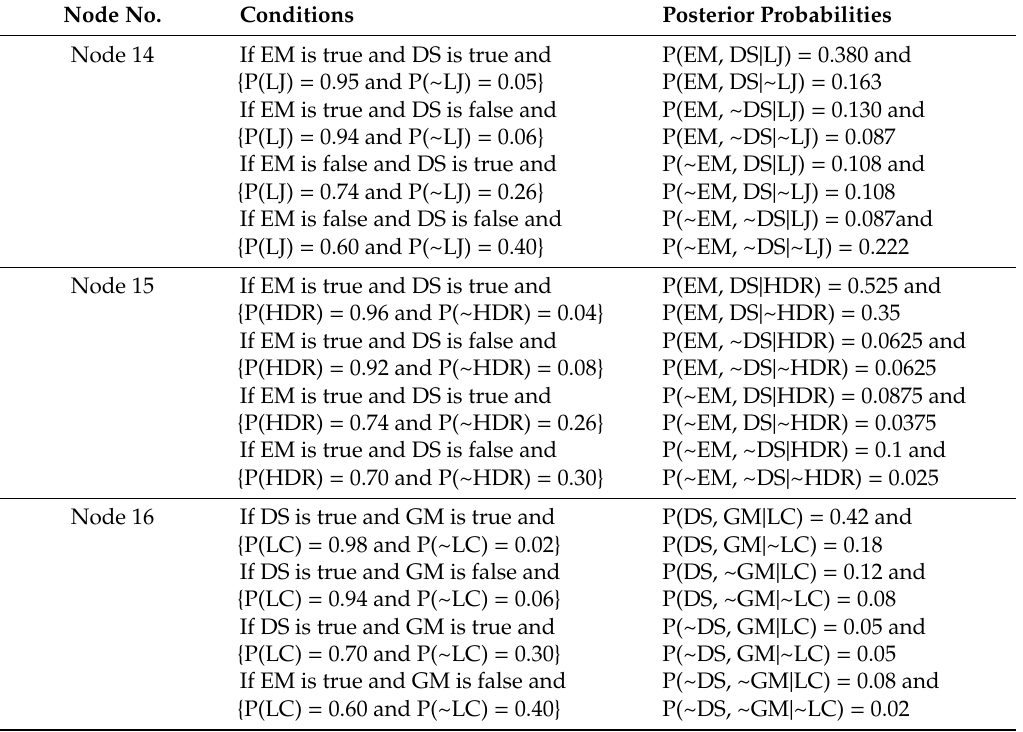
Table 4. Posterior probabilities for nodes